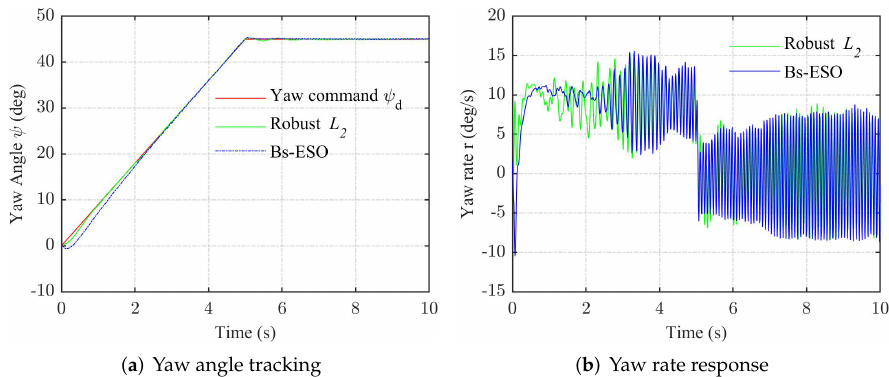
Figure 8. Linear tracking performance in the presence of a harmonic motor fault.